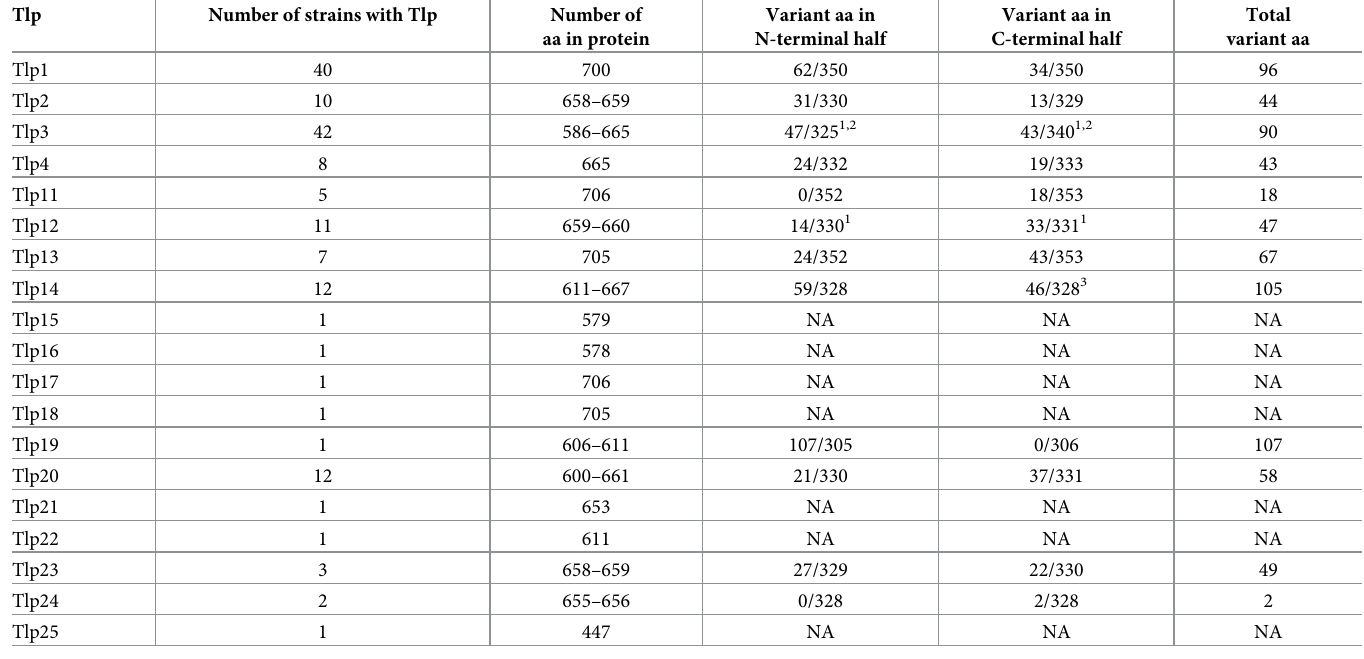
Table 1. Variability of amino acids in Cj and Cc Tlp